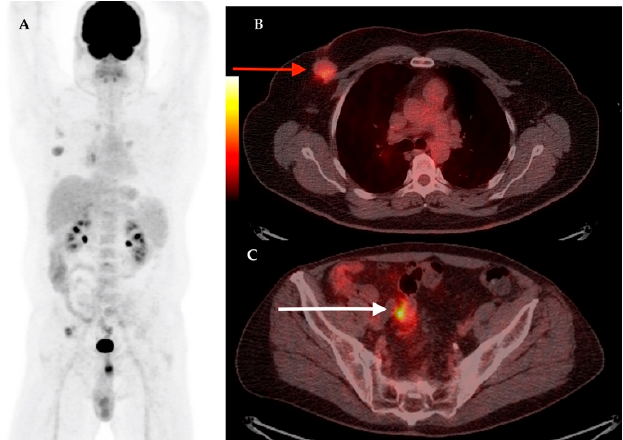
Figure 6. Male patient with right breast cancer. Synchronous confirmed colonic adenocarcinoma. MIP image on F18-FDG PET/CT ( A ); axial section at thorax level showing right breast lesion with increased F18-FDG uptake confirmed breast carcinoma on biopsy ( B , red arrow); axial section at pelvic level showing pathologic increased F18-FDG uptake in the colon ( C , white arrow), confirmed colon adenocarcinoma in biopsy at colonoscopy.